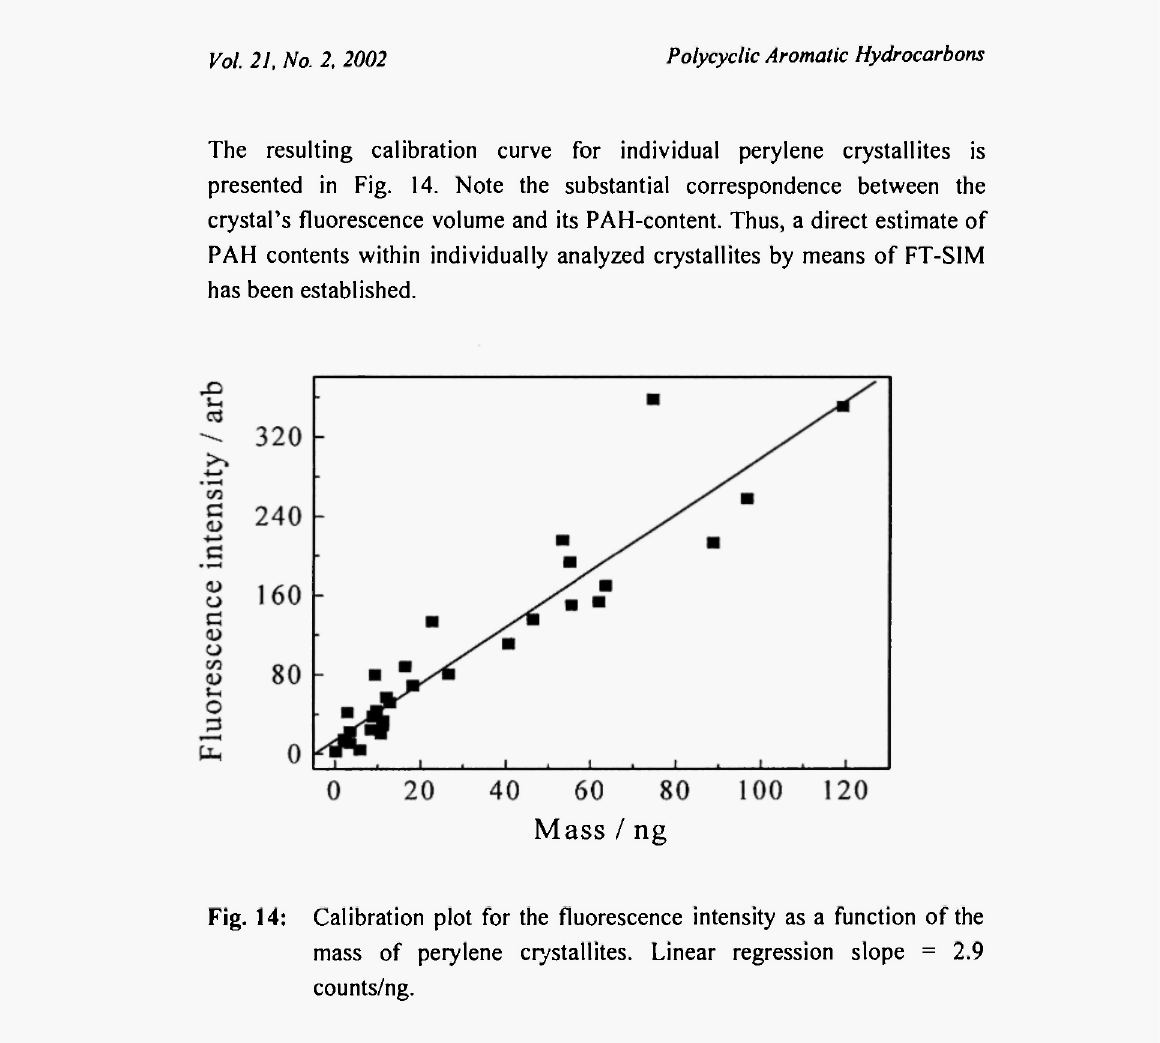
Fig. 14: Calibration plot for the fluorescence intensity as a function of the mass of perylene crystallites. Linear regression slope = 2.9